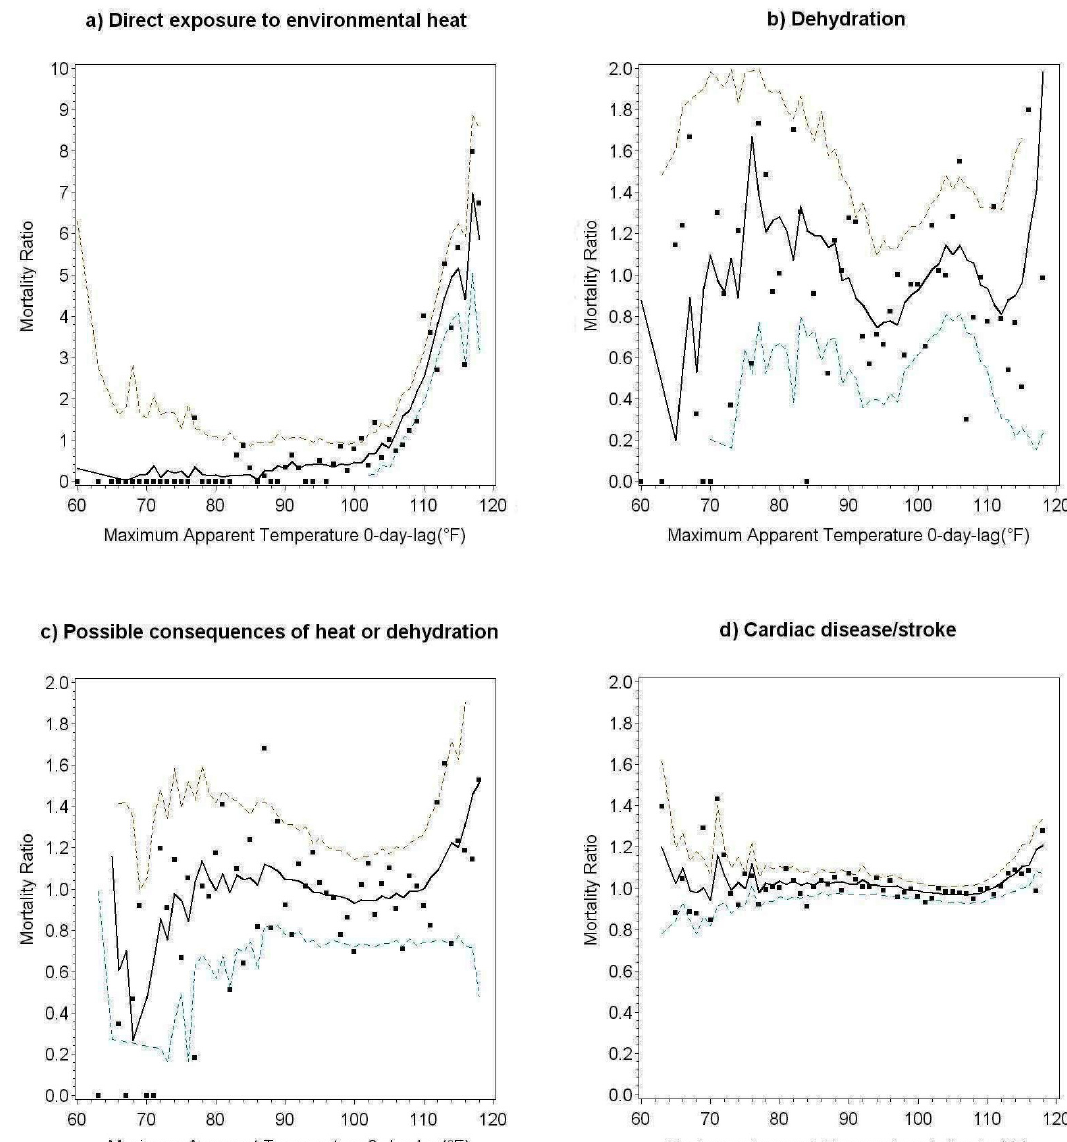
Figure 2. Temperature-mortality relationships for cause-specific categories and all-cause deaths for Maricopa County residents (all ages) during the months May–October for years 2000–2008. Small black squares ■ are the average mortality ratios ( P in Equation (2)) or i,j,k ratio of number of actual deaths to average deaths per day aggregated for all years) at a ). Values < 1.0 indicate fewer than expected given maximum apparent temperature (AT max deaths; values > 1.0 indicate more than expected deaths. Note the scale of mortality ratio on the y-axis in ( a ) is different from the other graphs. Solid black lines are the cubic spline regressions predicting daily average mortality ratios at AT (unsmoothed). Dashed lines max are the upper and lower 95% confidence intervals